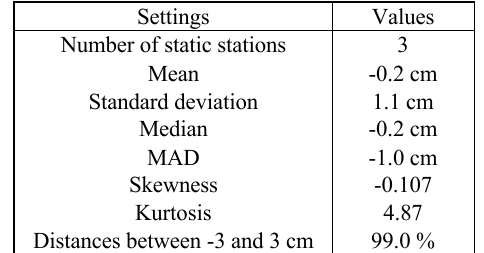
Figure 12. Representation of M3C2 signed distances for loop 2.